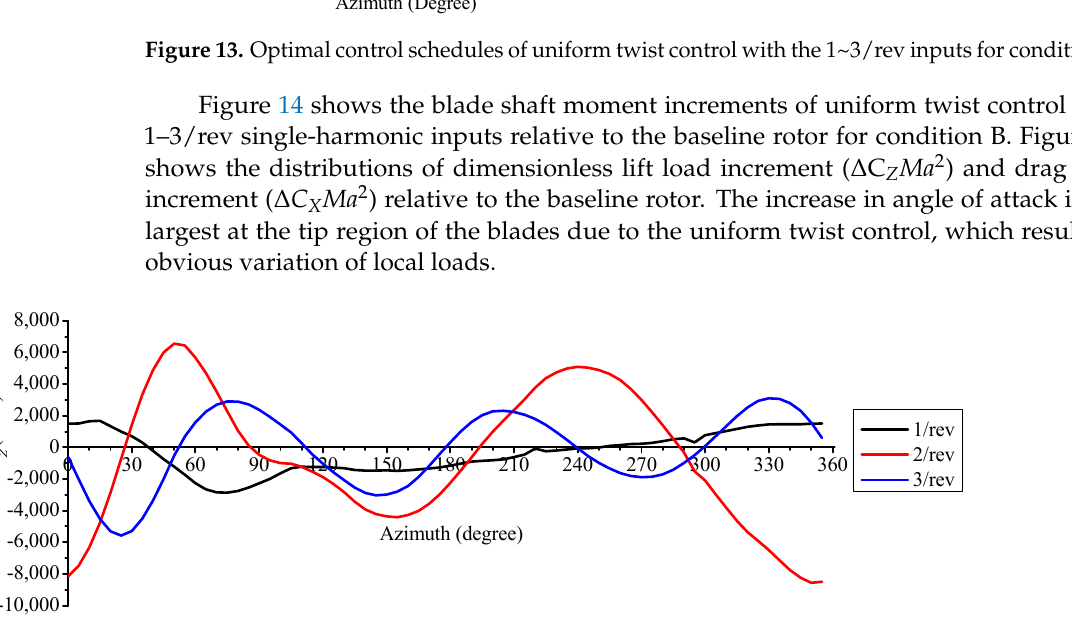
Figure 14. Blade shaft moment increments of uniform twist control with the 1~3/rev single-harmonic inputs relative to the baseline rotor for condition B.